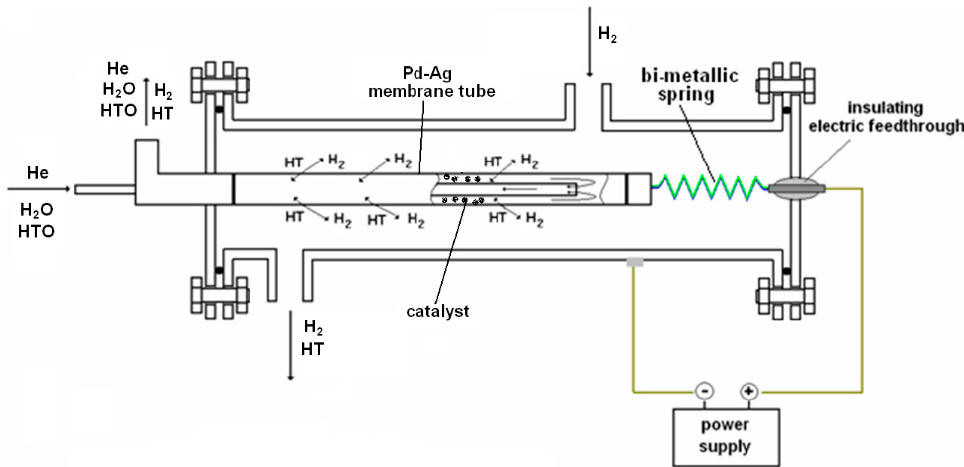
Figure 4. Scheme of the membrane reactor powered by direct ohmic heating (“Reprinted from Fusion Engineering and Design vol. 86, S. Tosti, C. Rizzello, F. Borgognoni, N. Ghirelli, A. Santucci, P. Trabuc, Design of Pd-based membrane reactor for gas detritiation, Pages 2180–2183, Copyright (2011), with permission from Elsevier.”) [26].